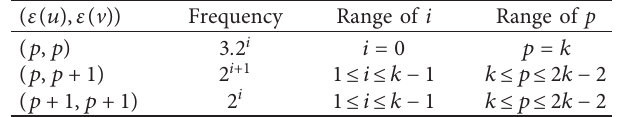
Table 2: Edge partition of a hypertree ( k -level) based on eccen- tricity of end vertices of each edge with existence of its frequencies.